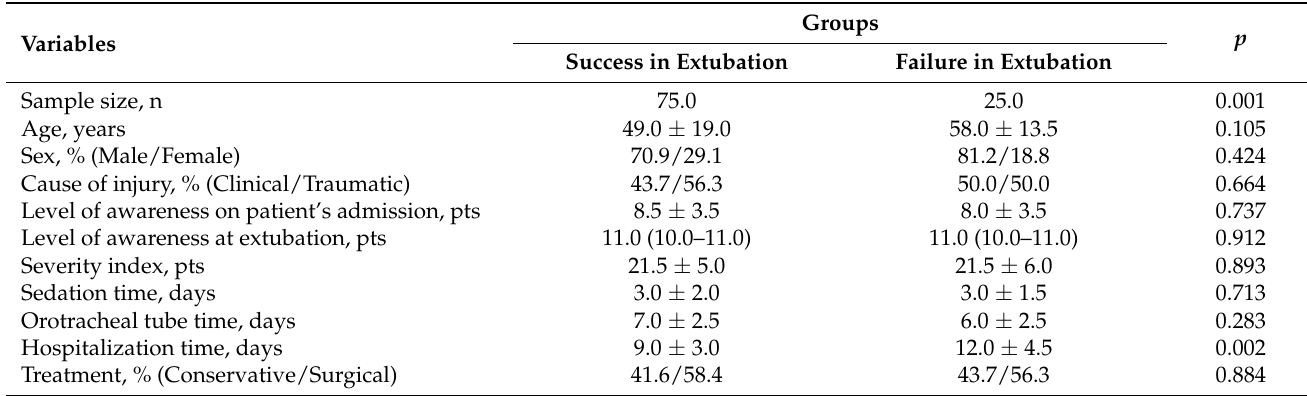
Table 1. General characteristics of the participants.